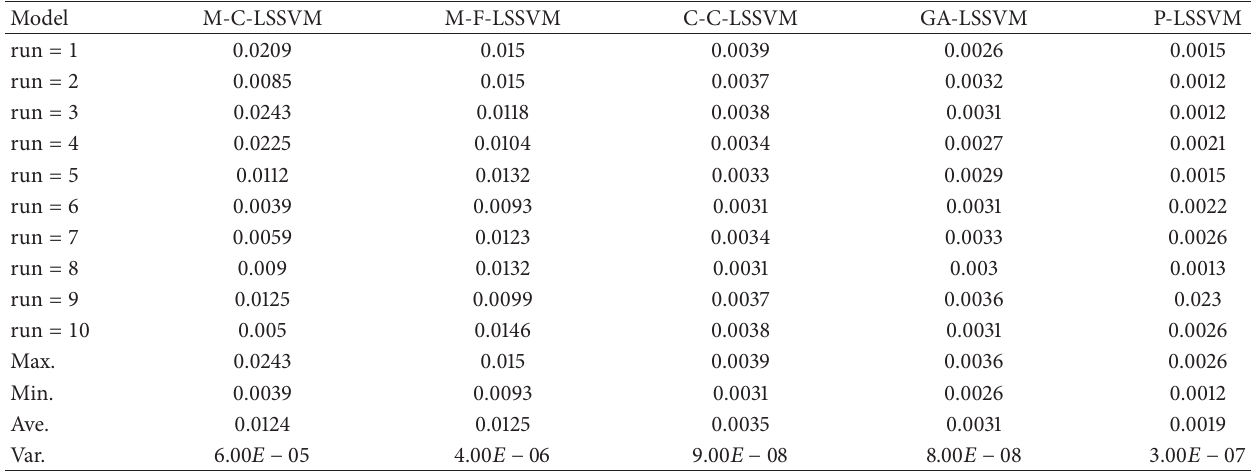
Table 14: Five models predicted error based on MASE for interphone